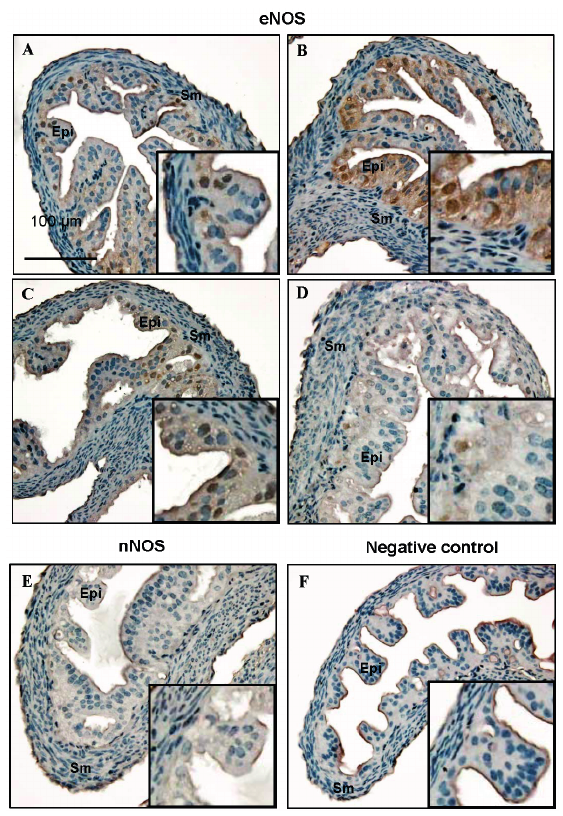
Figure 4. The eNOS expression in the mouse Fallopian tube by immunochemical methods and diaminobenzidine (DAB) staining. All slides were counterstained with hematoxylin. Enlarged views of one part are shown in the lower right corners in each picture. Epi, epithelial cells; Sm, smooth muscle cells; ( A ) Diestrus; ( B ) Proestrus; ( C ) Estrus; ( D ) Metestrus; ( E ) nNOS expression in the proestrus stage; and ( F ) Negative control using goat serum instead of the primary antibody showing the absence of staining. Scale bar = 100